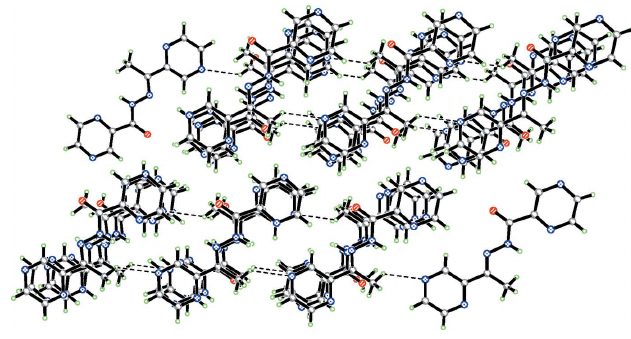
Figure 2 Crystal packing viewed along the b -axis direction.